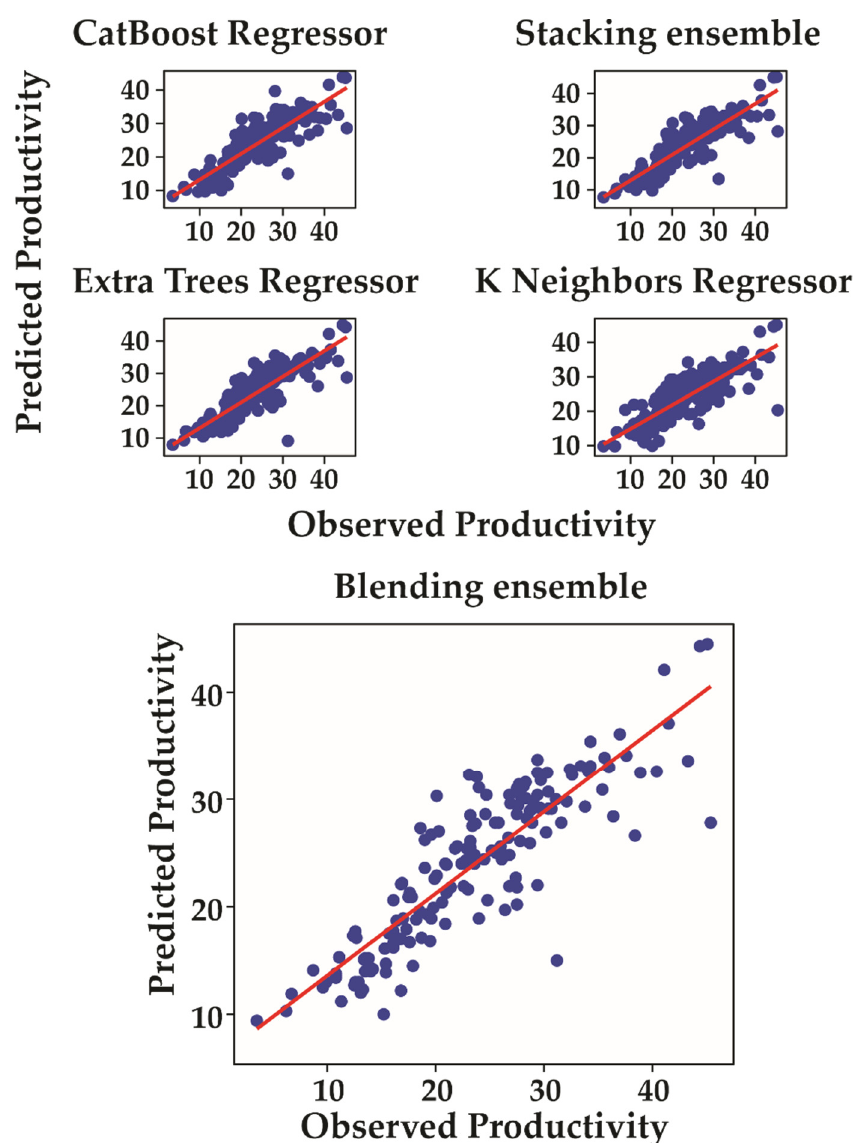
Figure 2. Comparison of scatter plot values of employed models.